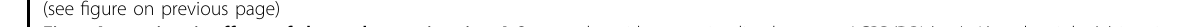
Fig. 7 Anorexigenic effects of chemotherapy in mice. A Scatter plot with regression line between ACBP/DBI (ng/mL) and weight (g) in mice with and without cancer. Pearson ’ s correlation coef fi cient (R) and their p value and number of samples available ( n ) are shown in the legend of each panel. B , C Metabolic effects in anorexic mice due to chemotherapy. Mice were treated with PBS or cisplatin (CDDP: 4 mg/kg) every week for 40 days. Body weight was monitored ( B ) and plasma ACBP levels were quanti fi ed on day 39 ( C ) ( n = 8 – 10 mice per group). Body weight PBS versus CDDP p < 0.001. D , E Metabolic effects of ACBP expression in anorexic mice due to chemotherapy. Mice received hydrodynamic injections of empty pLIVE or pLIVE- ACBP (100 µg) expressing vector at day 2. Three days after, mice were treated with PBS or cisplatin (CDDP: 4 mg/kg) once per week. Body weight was monitored ( D ) and plasma ACBP concentrations were measured in the CDDP treated mice at day 8 ( E ) ( n = 8 – 10 mice per group). Body weight pLIVE-empty PBS versus pLIVE-empty CDDP p < 0.001. Body weight pLIVE-empty PBS versus pLIVE-ACBP CDDP p = 0.75. Body weight pLIVE-empty CDDP versus pLIVE-ACBP CDDP p <